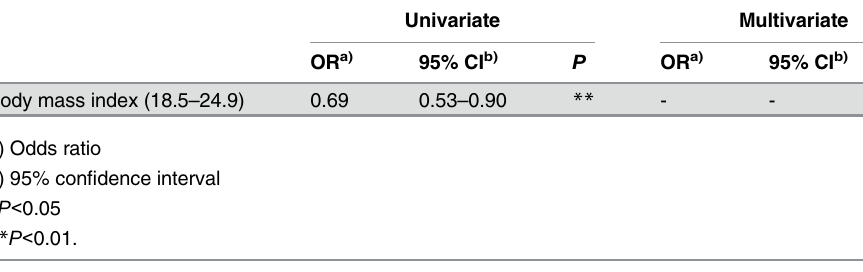
Table 5. Factors associated with therapeutic failure in chronic kidney disease (n = 961) (logistic regression